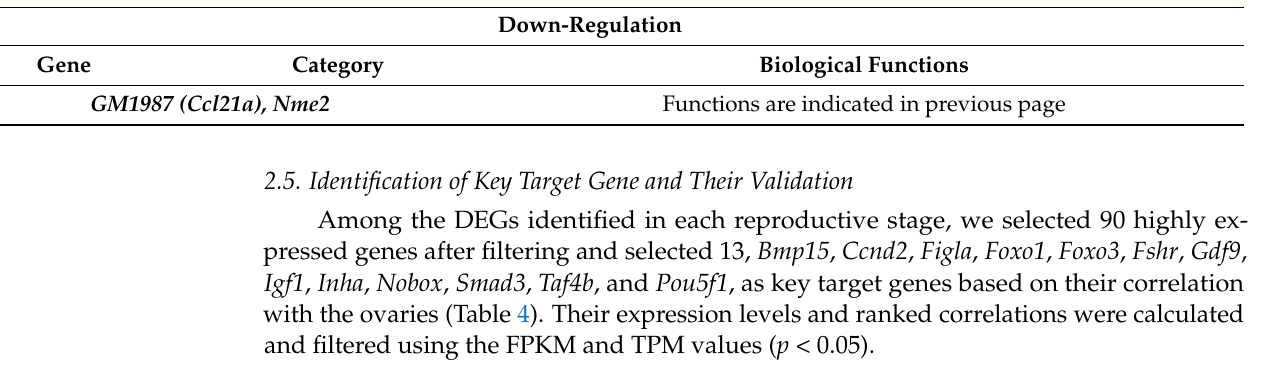
Table 3. Cont. (F) 20 W vs. 15 W